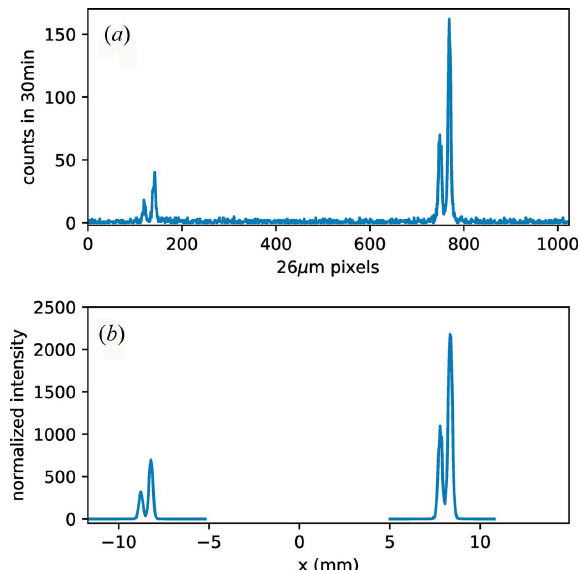
Figure 3 Ni (left) and Cu (right) K (cid:2) peaks reflected from a 200 HUF coin onto the detector via the conical von Ha´mos crystal. Panel ( a ) shows experimental data, panel ( b ) the result of the ray tracing. Abscissas share the same scale, shown in pixel numbers in ( a ) and distances in millimetres in ( b ). The CCD detector has 26 m m (cid:3) 26 m m pixels.